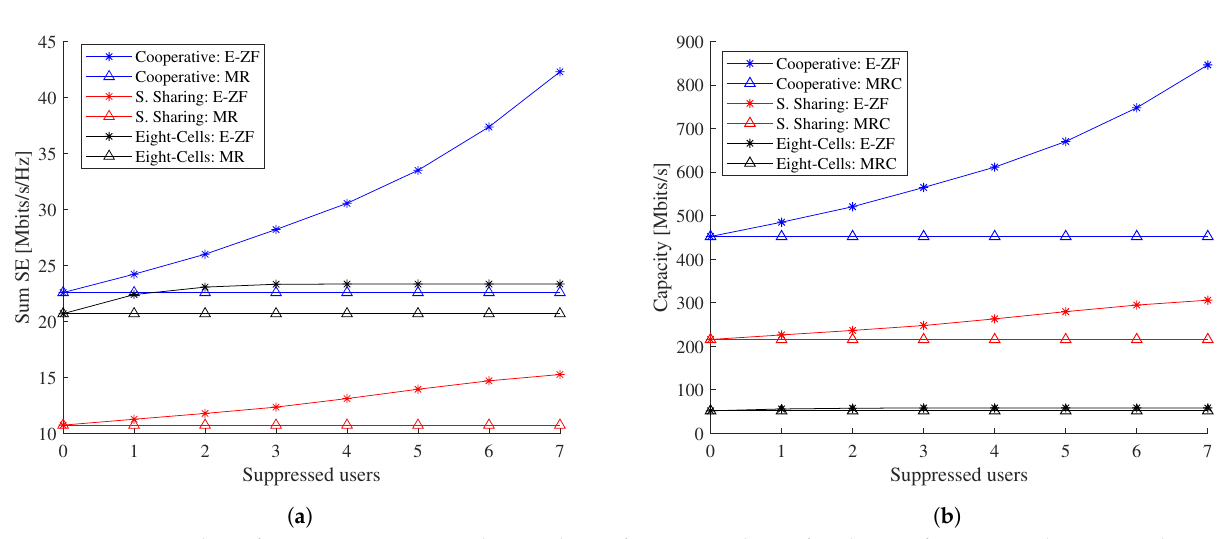
Figure 6. Network performance metrics vs. the numbers of suppressed interfered users for E-ZF and MRC combining vectors. The analysis includes three system configurations: Cooperative, Spectrum Sharing and Eight-Cell,